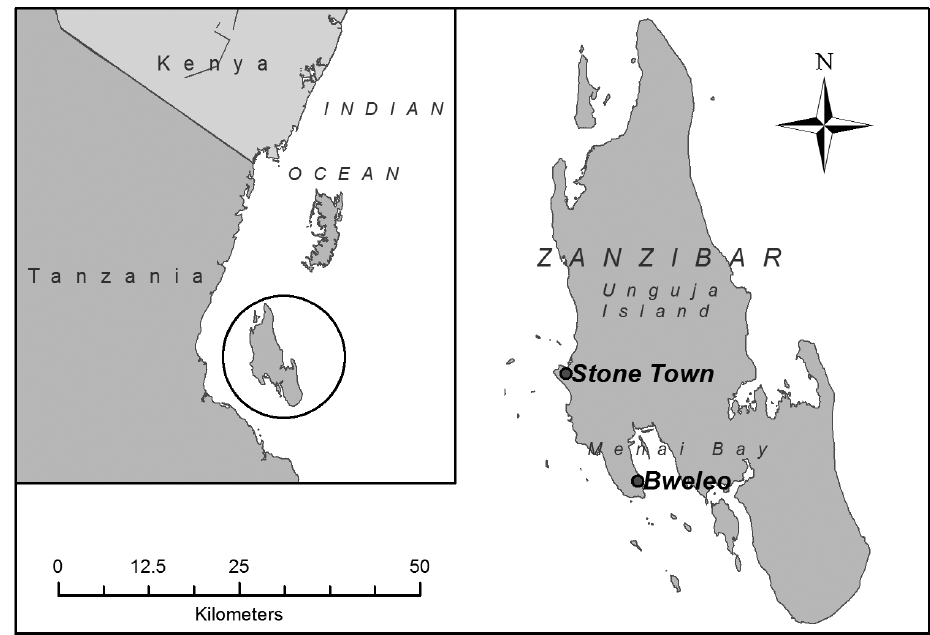
Fig. 1. Location of the experimental site in the coastal area of Bweleo on Unguja Island, Zanzibar,